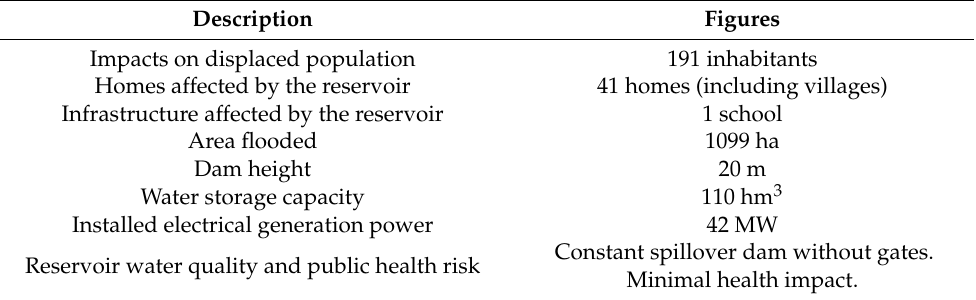
Table 2. Socio-environmental impacts and technical specifications of the alternative design.